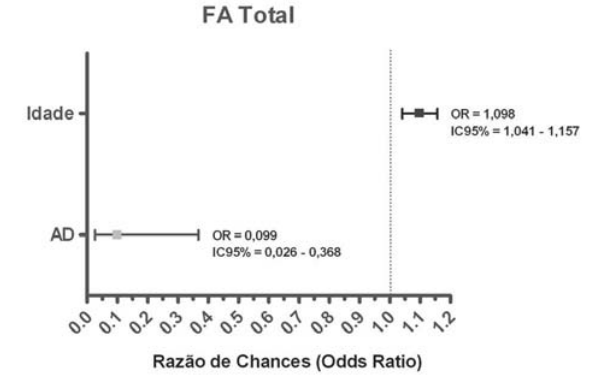
Fig. 3 - Fatores de risco e a razão de chances (odds ratio) para o aparecimento de FA durante o período de internação hospitalar 5. Fatores de risco e a razão de chances ( Odds Ratio ) para o aparecimento da FA no